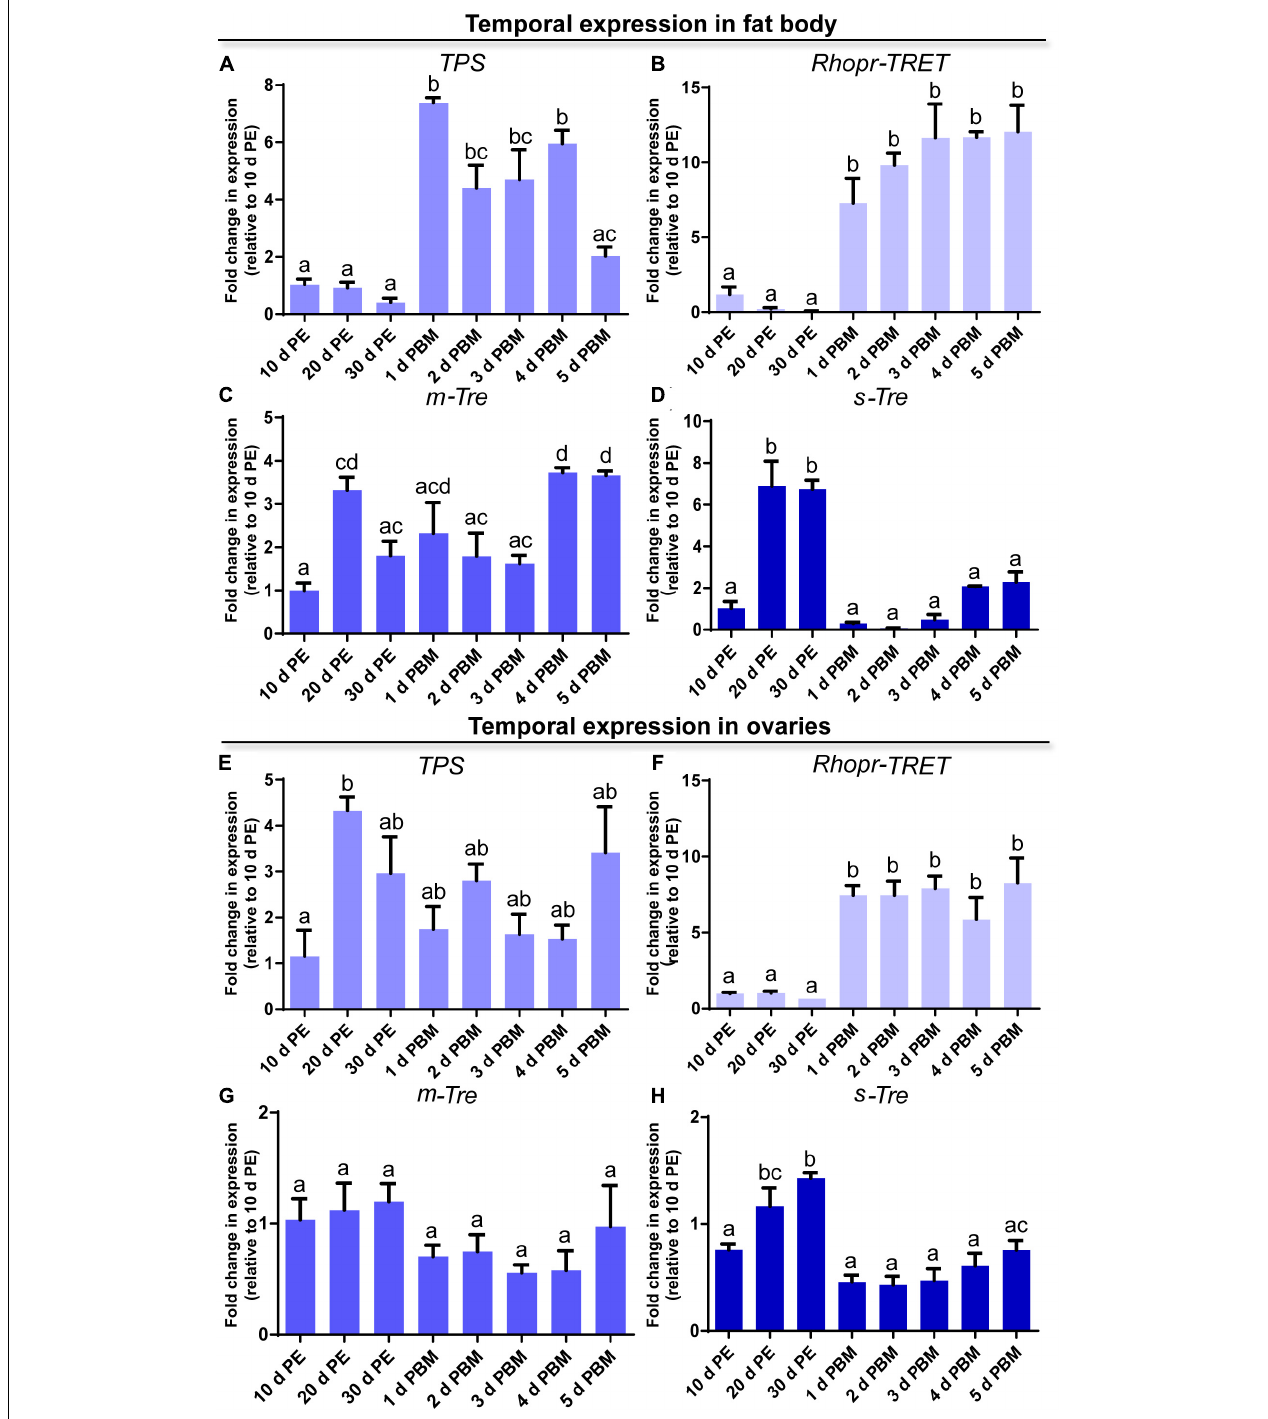
FIGURE 3 | Temporal expression of trehalose synthase ( TPS ), Rhopr-TRET , membrane-bound trehalase ( m-Tre ), and soluble trehalase ( s-Tre ) in the fat body and ovaries of R. prolixus under different nutritional conditions. Transcript expression of TPS , Rhopr-TRET , m-Tre , and s-Tre was quantified by RT-qPCR in the fat body ( A–D , respectively) and ovaries ( E–H , respectively) of adult females at varying days post-ecdysis (d PE), representing unfed conditions, and various days post-blood meal (d PBM), representing the fed condition. Results were analyzed by the (cid:49)(cid:49) C t method. The y -axis represents the fold change in expression relative to 10 days PE (value ∼ 1). The results are shown as the mean ± SEM ( n = 3–4, where each n represents a pool of tissues from 3 insects). Statistically significant differences were determined by a one-way ANOVA and a Tukey’s test as the post hoc test. Different letters indicate significant difference at P <